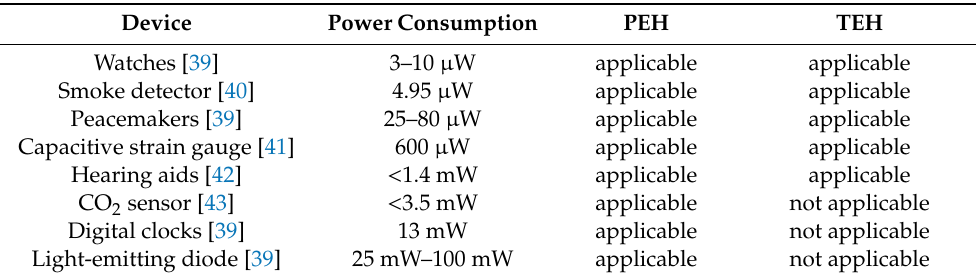
Table 3. Power consumption of common small electronic devices.